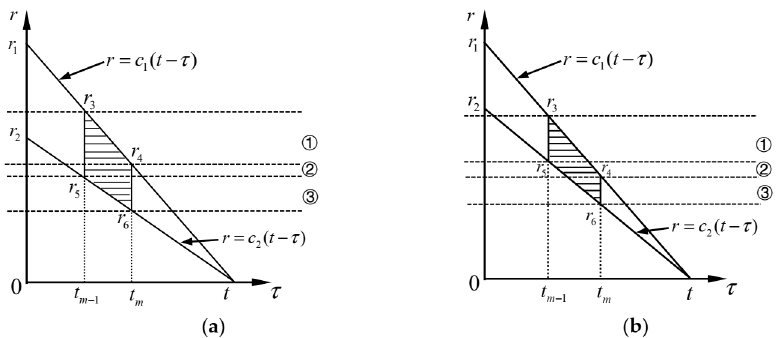
Figure 3. Subdivision of ATI-TSD in [ t m − 1 , t m ]: ( a ) the case of r 4 > r 5 ; ( b ) the case of r 4 < r 5